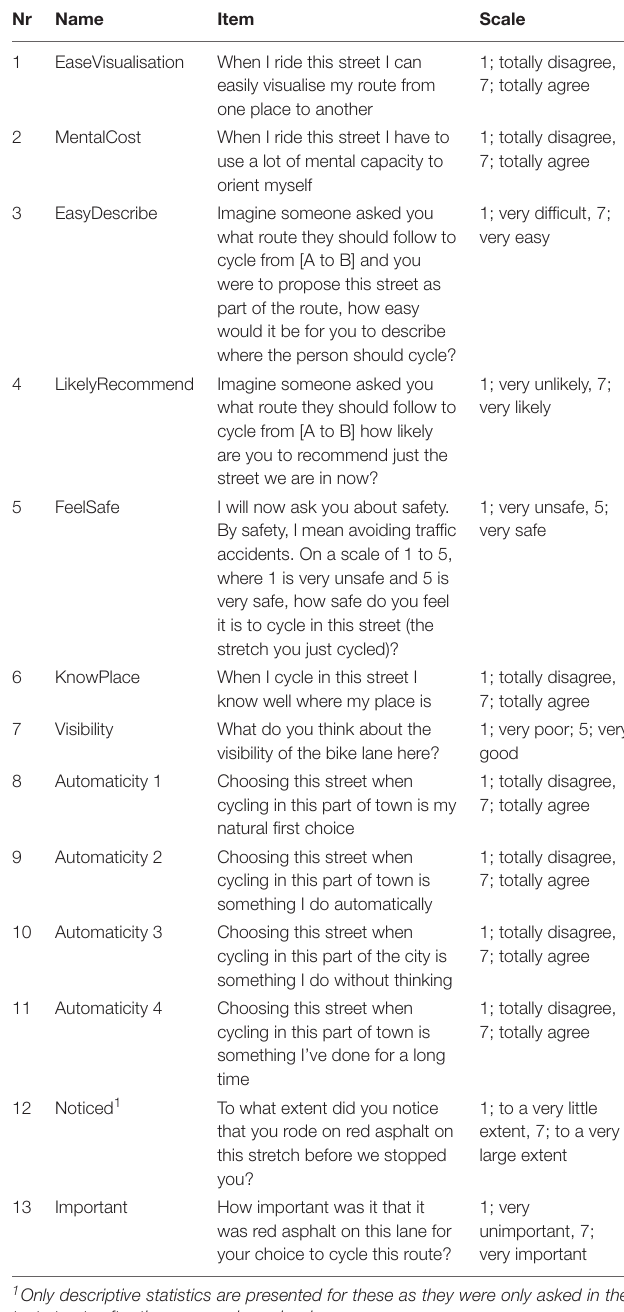
TABLE 2 | Survey items included in